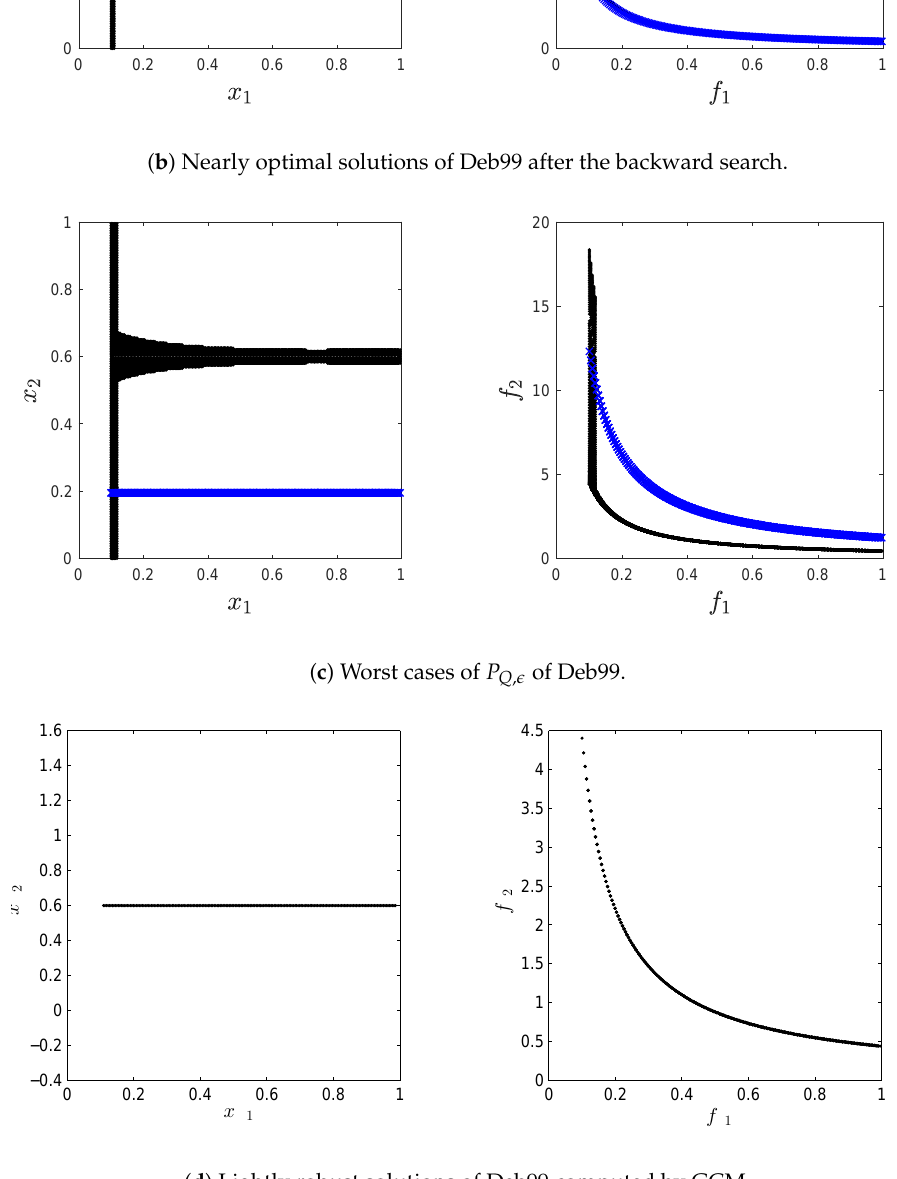
Figure 1. Numerical results on Deb99. In blue, the nominal Pareto set/front. It is posible to observe that due to the uncertainty, the global nominal front deteriorated up to the point that it becomes dominated by the local